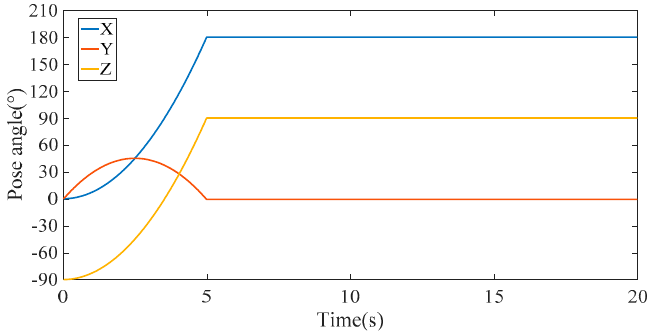
Figure 18. The pose angle of the end of the manipulator in the simulation.